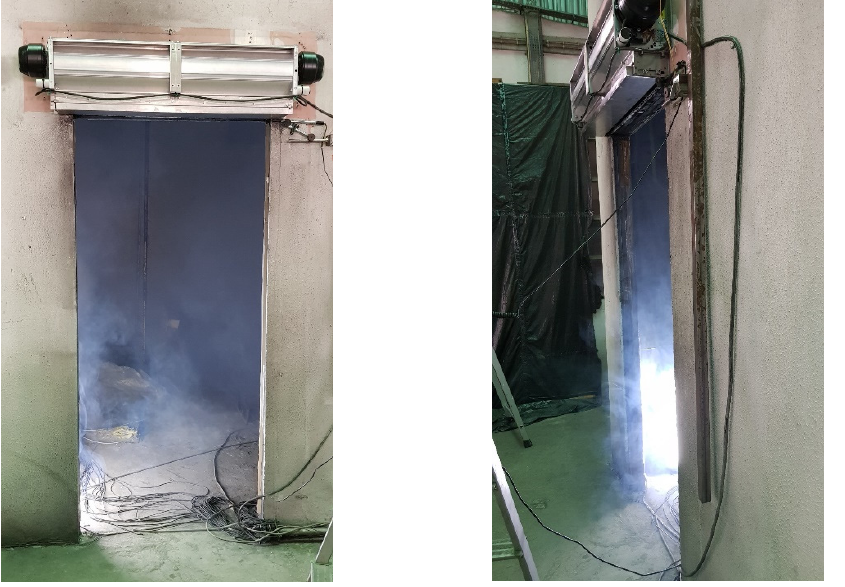
Figure 5. Front view and profile view of the cold smoke escaping the compartment during the tests.